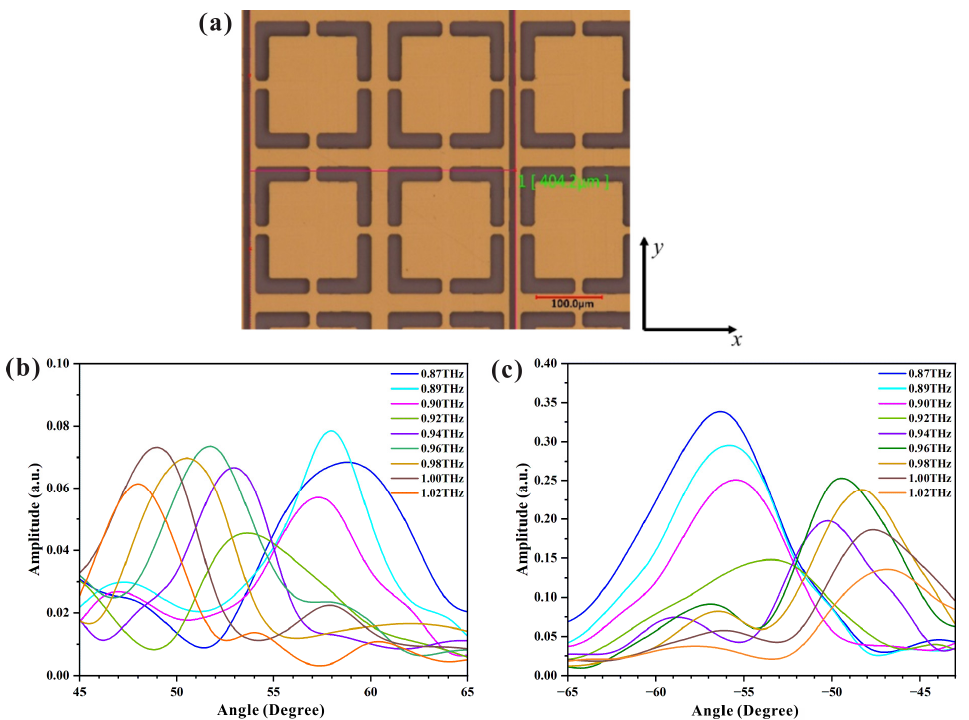
Figure 3. ( a ) The optical micrograph of the fabricated metasurface grating; the measured results of the diffraction wave. ( b ) +1st order mode; ( c ) − 1st order mode.